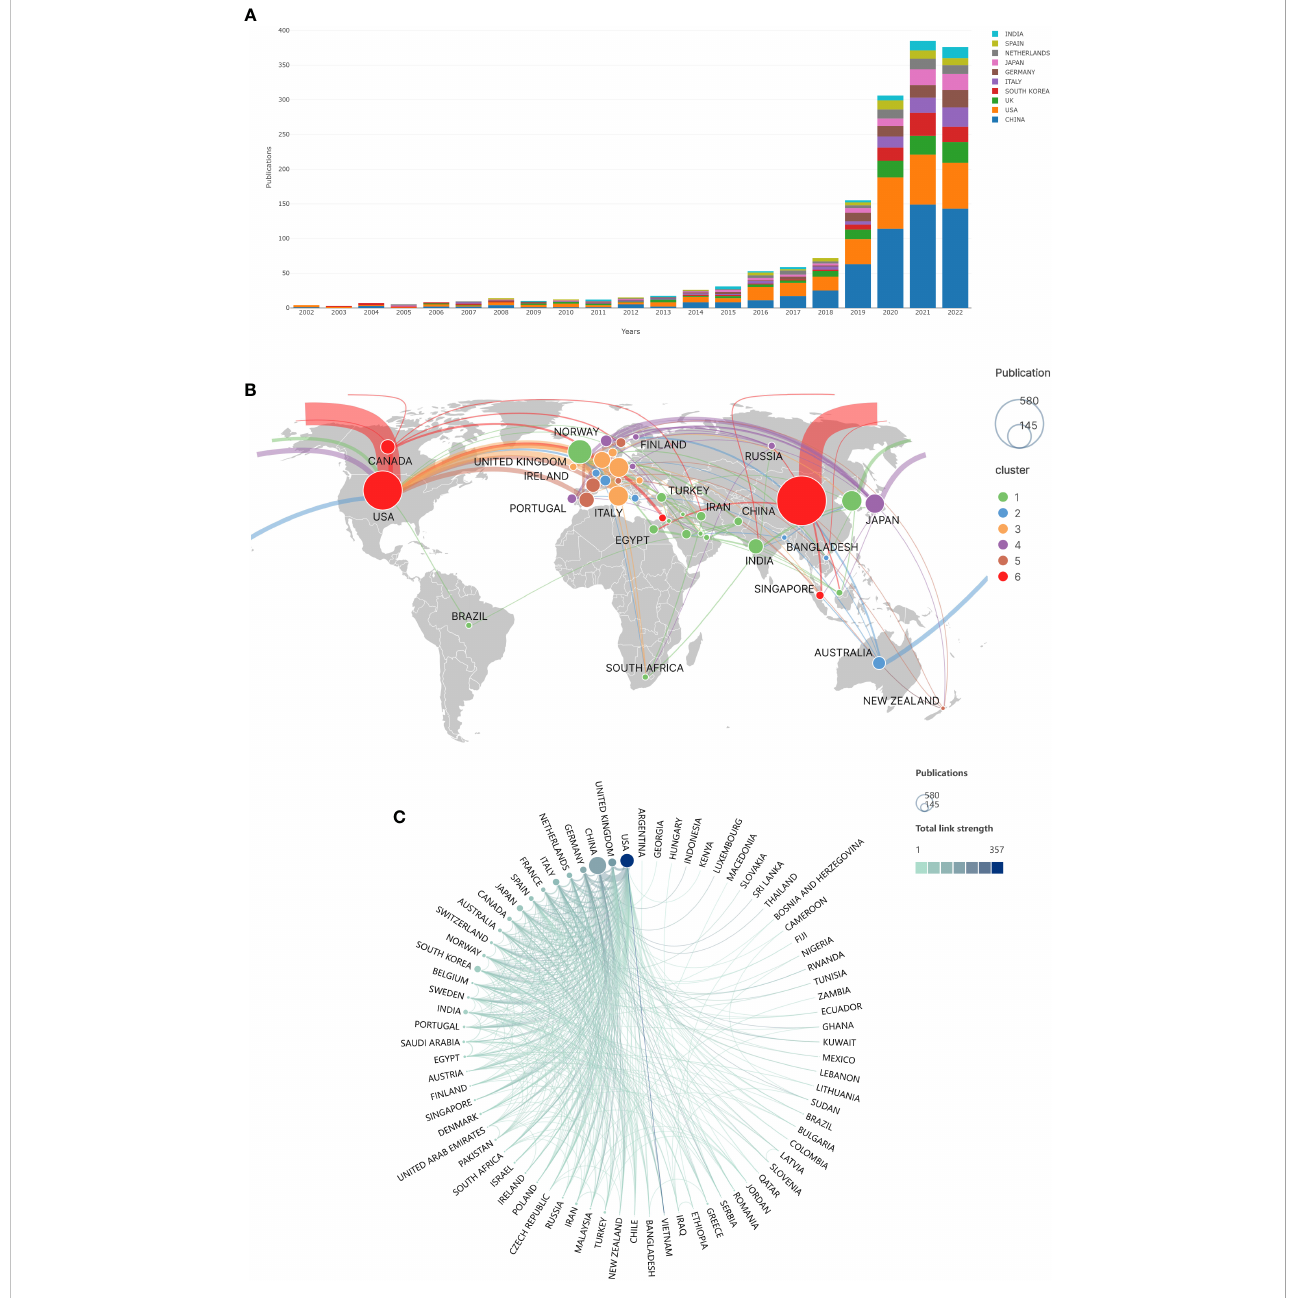
FIGURE 2 Publications and cooperation in different countries/regions of the world. (A) Top 10 countries/regions with annual publication trends of AI in CRC. (B) Map of the world ’ s countries/regions in terms of publications and collaborations in the fi eld of AI in CRC. (The size of the circle represents the number of articles issued. The thickness of the connecting line represents the number of collaborative communications between countries. The color of the circles represents the intensity of cooperation. Countries with the same color cooperate more frequently with each other.). (C) Cooperation between countries/regions (The size of the circle represents the number of articles issued, and the thickness of the line represents the intensity of cooperation between